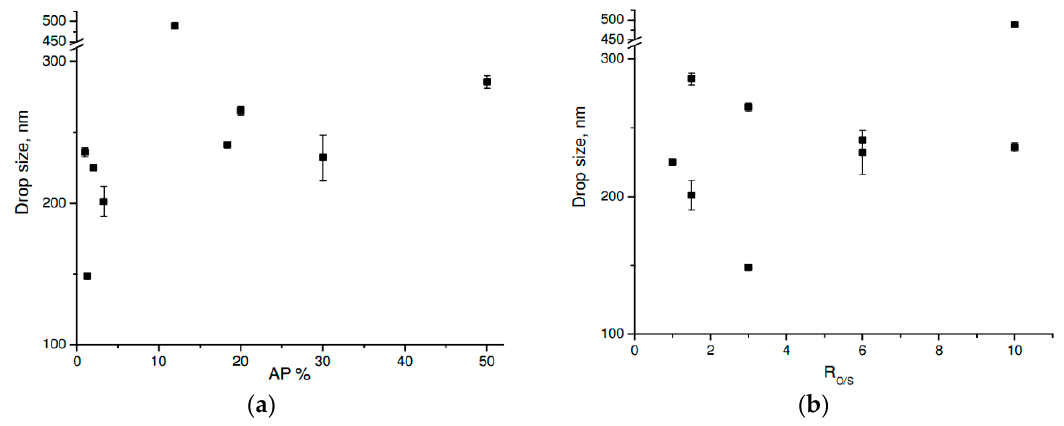
Figure 7. Drop size for the OP//AG54//AP system at T = 25 °C as a function of: ( a ) AP % and ( b ) R O/S .